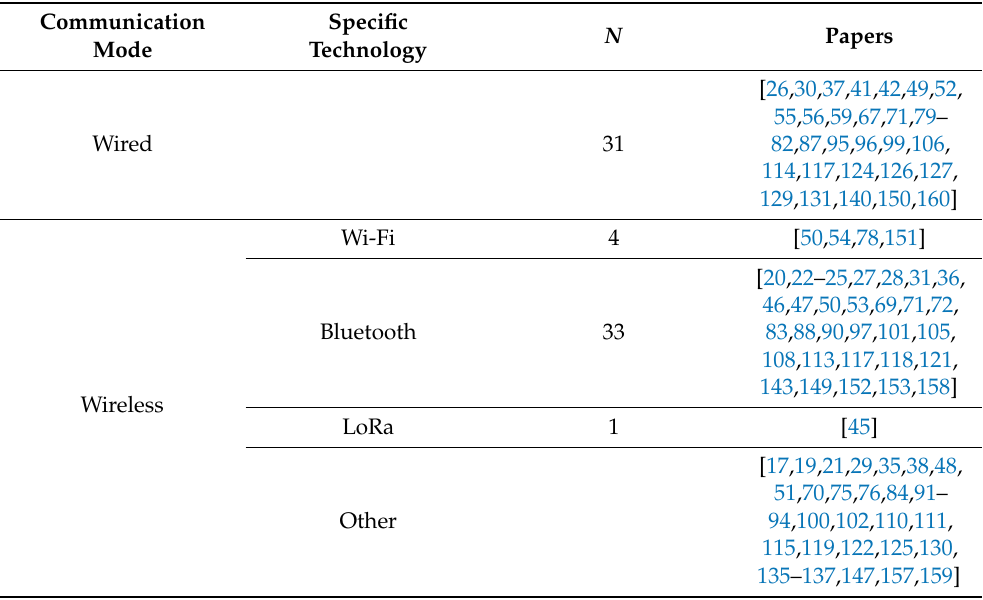
Table 8. Mode of communication used in the studies. Wireless mode is further divided into specific technologies. Some papers have not specified the communication type or technology. Communication Specific N Papers Mode Technology